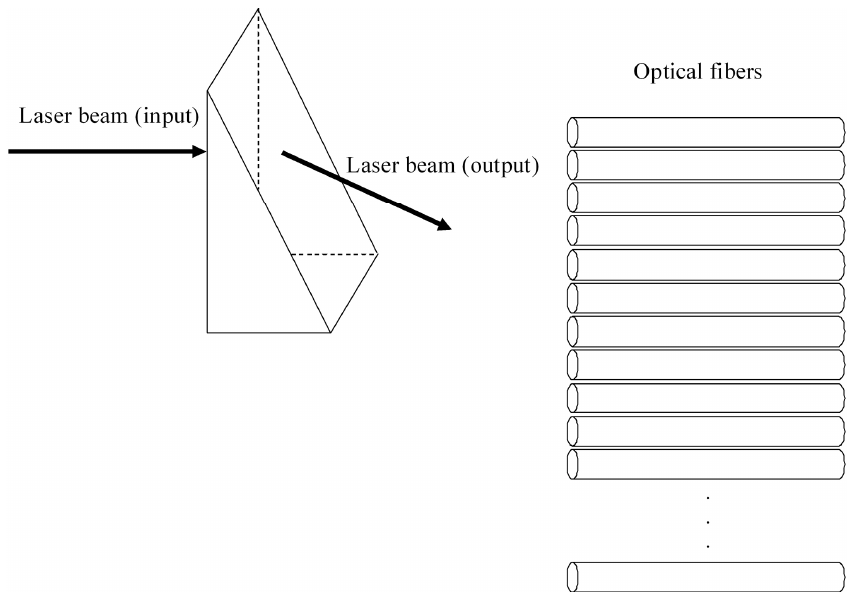
Figure 4. Scheme of the laser beam entering sequentially all the optical fibers. Output endface of each optical fiber is glued to a plasmonic sensor.